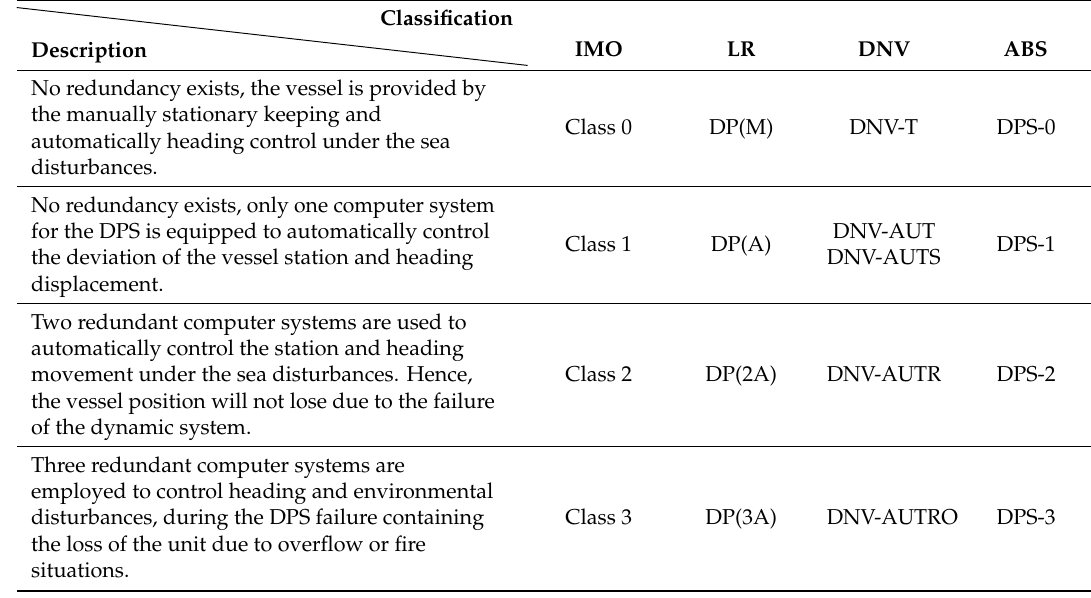
Table 1. Dynamic positioning vessel